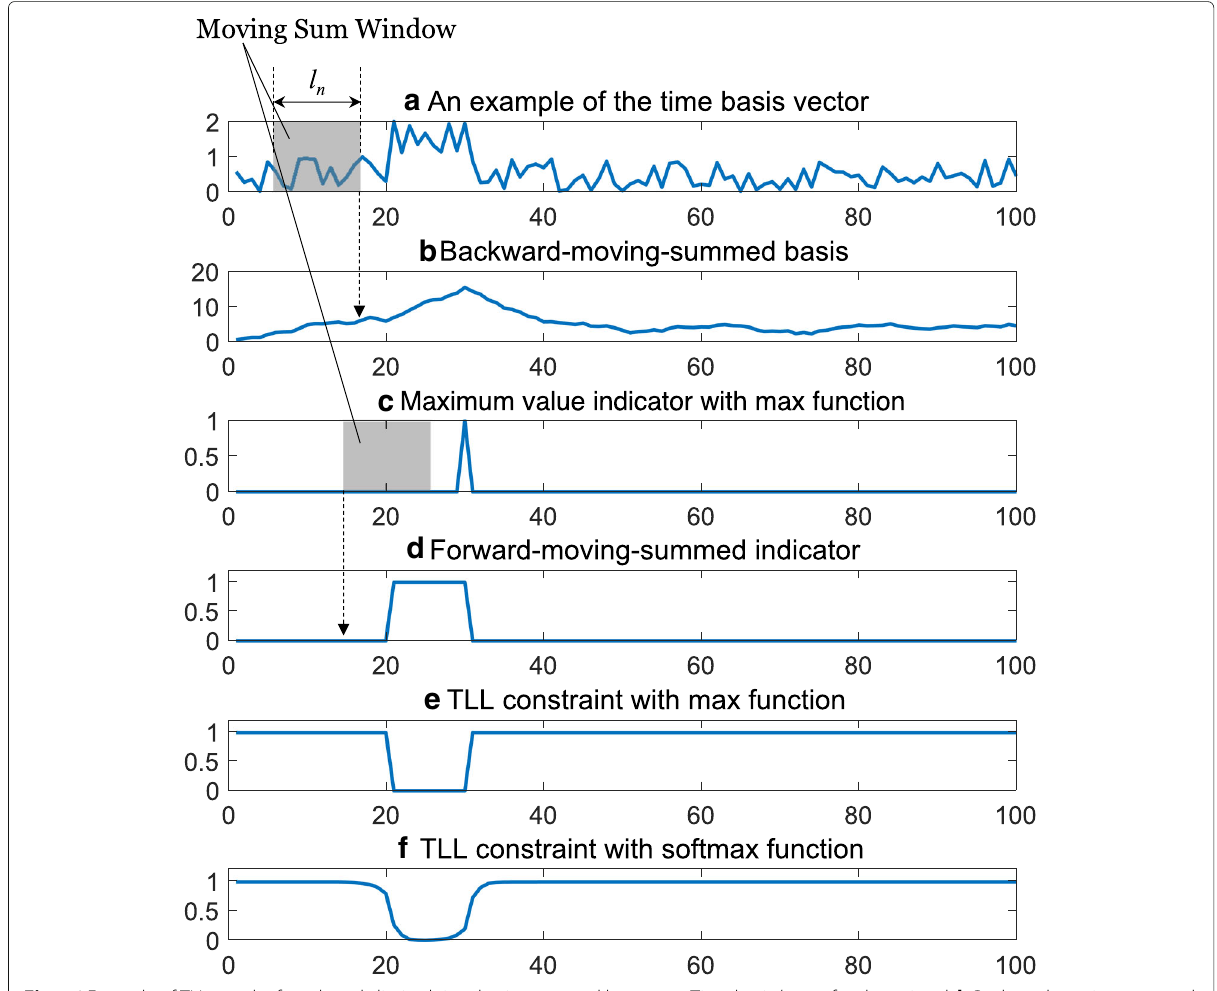
Fig. 16 Example of TLL penalty from length-limited time basis corrupted by error. a Time basis h p , ( r , n ) for short signal. b Backward-moving-summed time basis ¯ h p , ( r , n ) . c Maximum value indicator ˆ h p , ( r , n ) . d Forward-moving-summed indicator softmax